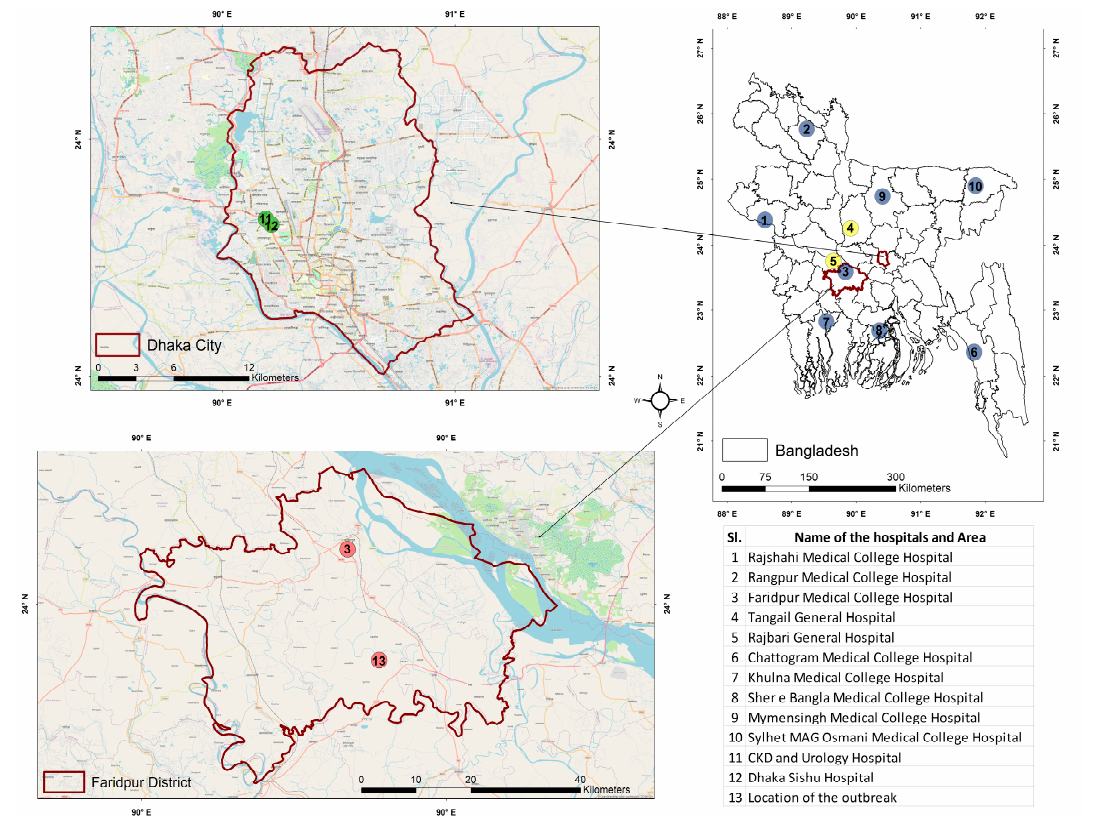
Figure 1. Map of Bangladesh, showing the locations of sentinel hospital-based surveillance sites (1–10); among them, two are passive surveillance sites (4, 5); healthcare facilities in Dhaka district, where confirmed Nipah cases were admitted (11–12) and the location of the outbreak at Faridpur district (Location of the household of “Case X”, “Case Y” and “Case Z”)